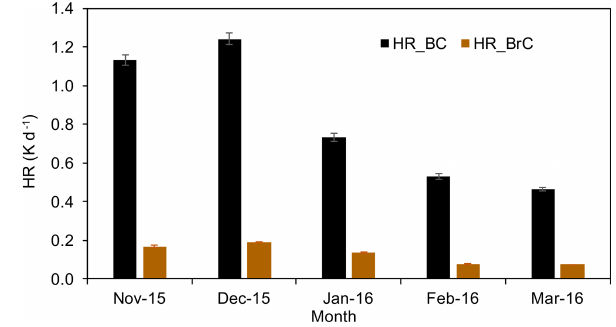
Figure 12. Average values of the total HR, HR dir , HR dif and HR ref as a function of the cloud type.